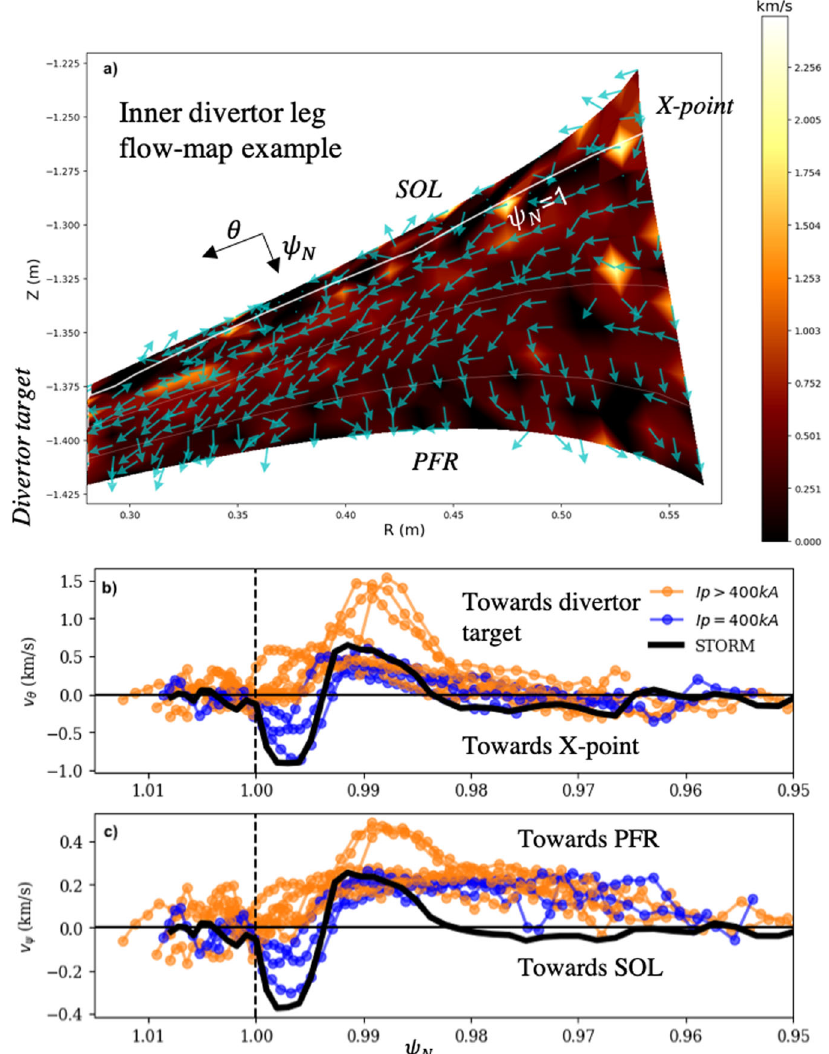
Fig. 5 Turbulent fl ow measurements in the inner divertor leg. a Example of a fl ow map measured in the inner divertor leg for a typical discharge showing scrape-off layer (SOL) and private- fl ux region (PFR) fl ows with the separatrix ( ψ N = 1 magnetic fl ux surface where ψ N is the normalised poloidal fl ux coordinate) shown as a white line. b Poloidal ( θ direction) and c ) radial ( ψ N direction) fl ows in the inner divertor leg averaged poloidally for all plasmas in the database. Blue traces indicate plasmas with a plasma current I p = 400 kA (matching conditions used for the STORM simulation) whilst orange traces indicate plasmas with I p >